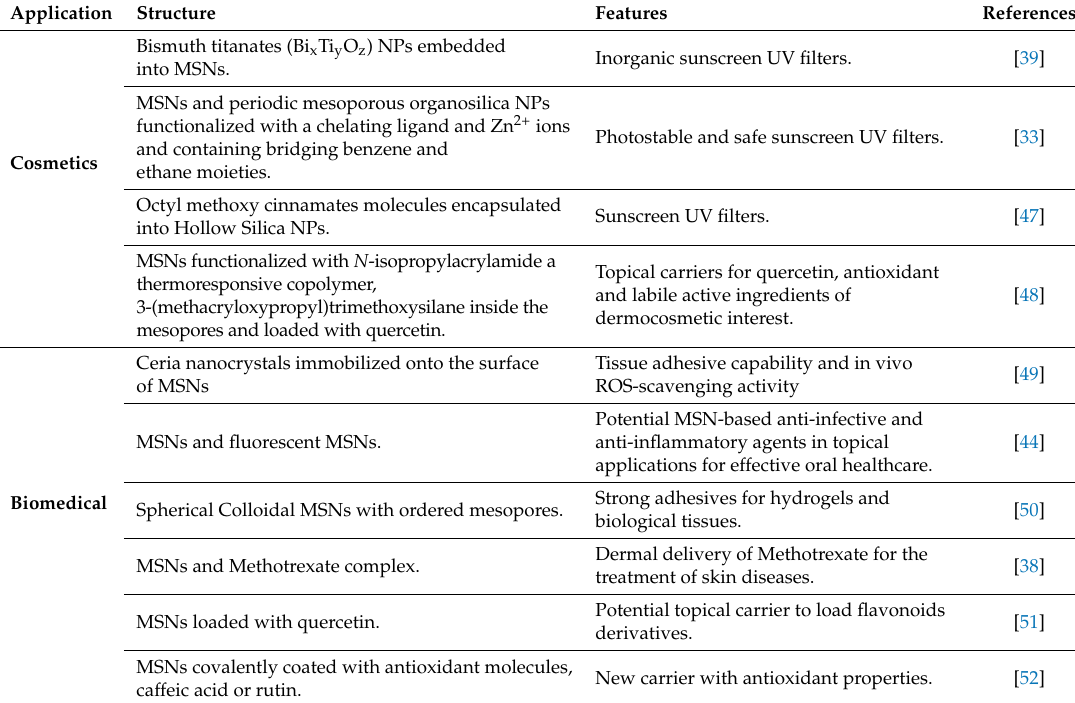
Table 1. Multifunctional Silica Nanoparticles (MSNs) as a versatile platform for Topical Drug Delivery. Application